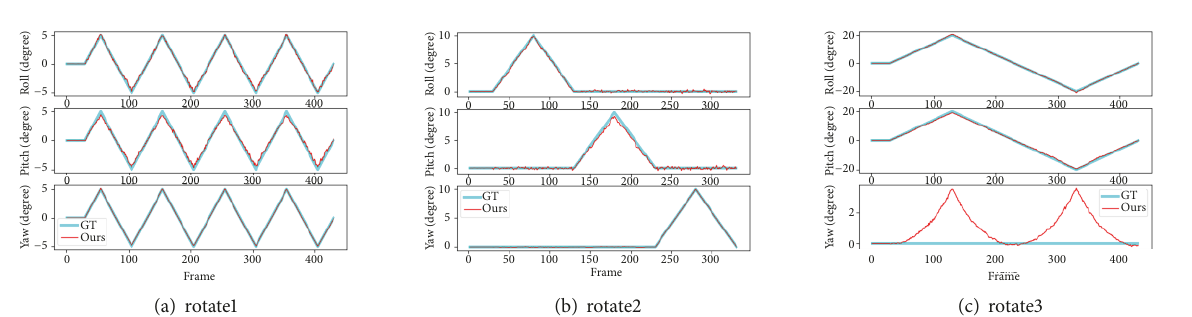
Figure 7: Comparison between the ground truth and our estimated pose on rotate sequences.